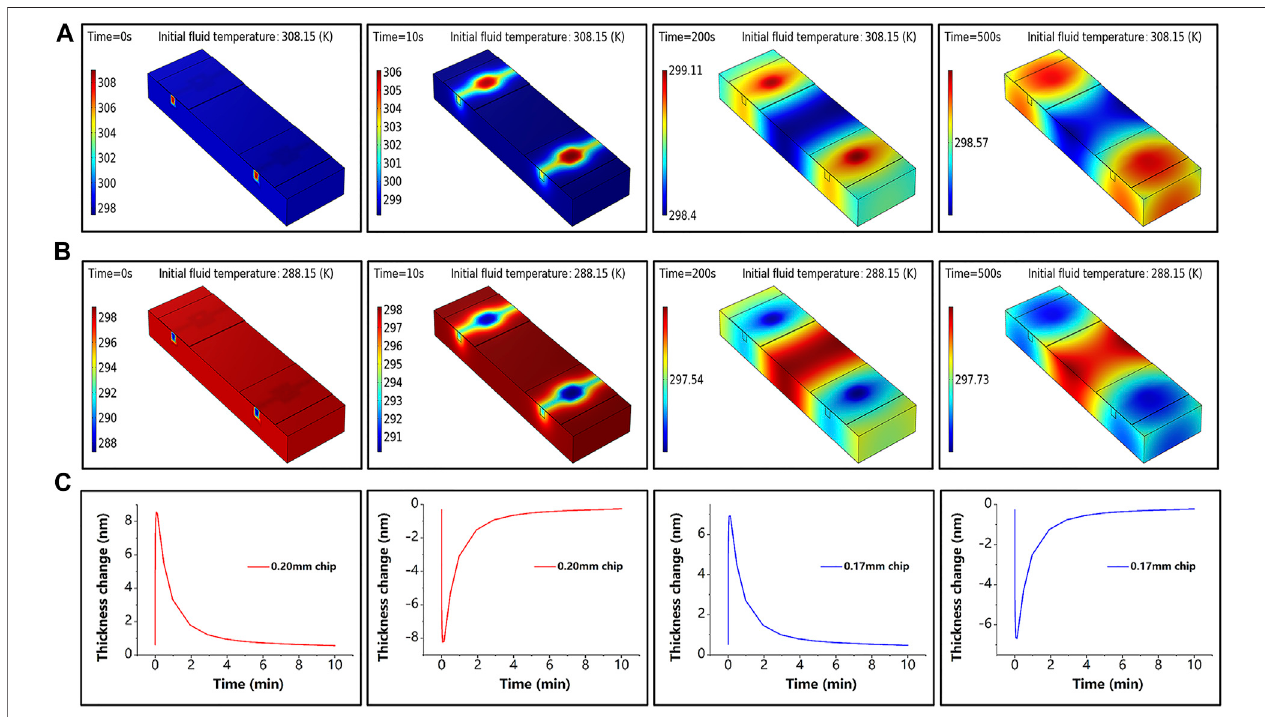
FIGURE 3 | Simulation results. (A) Sensor temperature at different moments under the initial temperature of fl uid of 308.15 K when the simulated ambient temperature increases. (B) Sensor temperature at different moments under the initial temperature of fl uid of 288.15 K when the simulated ambient temperature decreases. (C) Thickness variation at the center point of the sensing chip for different initial thicknesses during simulated temperature rise and fall; the red line corresponds to a thickness of 0.20 mm and the blue line to a thickness of 0.17 mm.